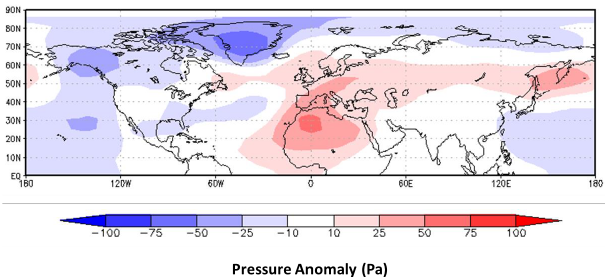
Figure 3. 9k0kEQ–9k9kEQ_OG 800hPa geopotential height, al- lowing the effects of changing vegetation in the Sahara, on pressure, to be visualised.